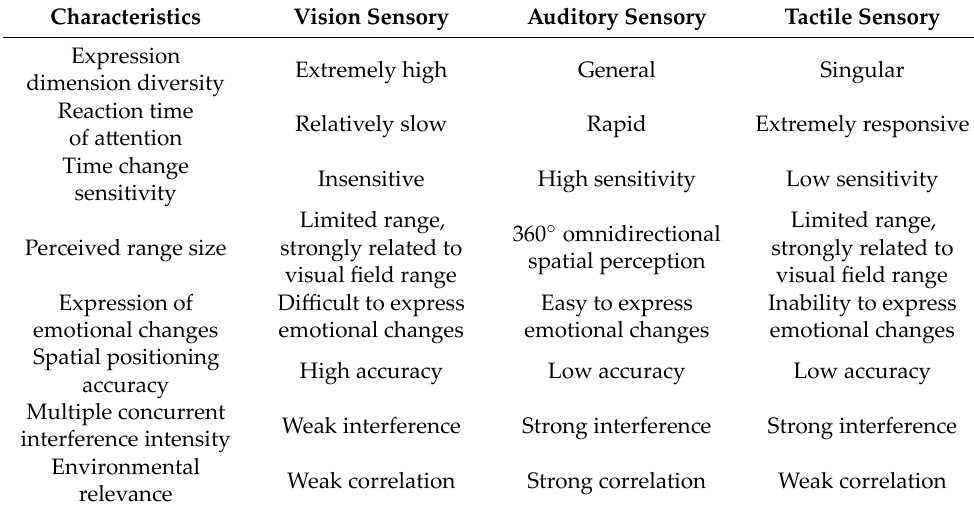
Table 2. Comparison table of information perception characteristics of visual, auditory, and tactile sensory